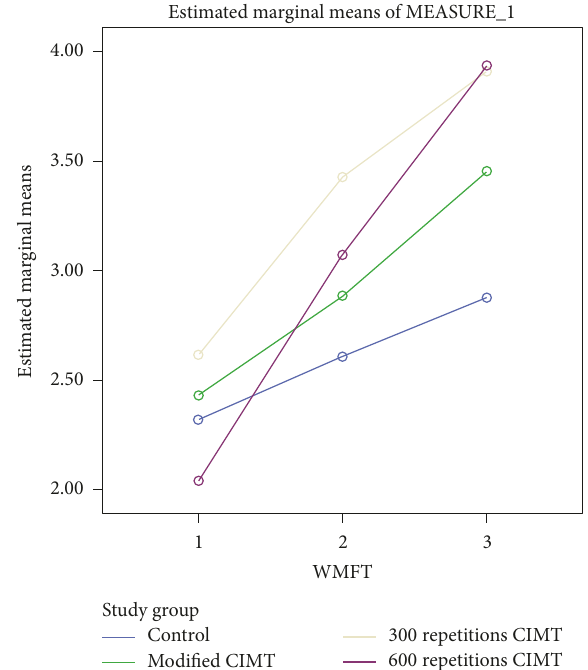
Figure 3: A profile plot showing groups’ mean scores in MAL (how well) at baseline, 2 weeks, and 4 weeks after intervention.